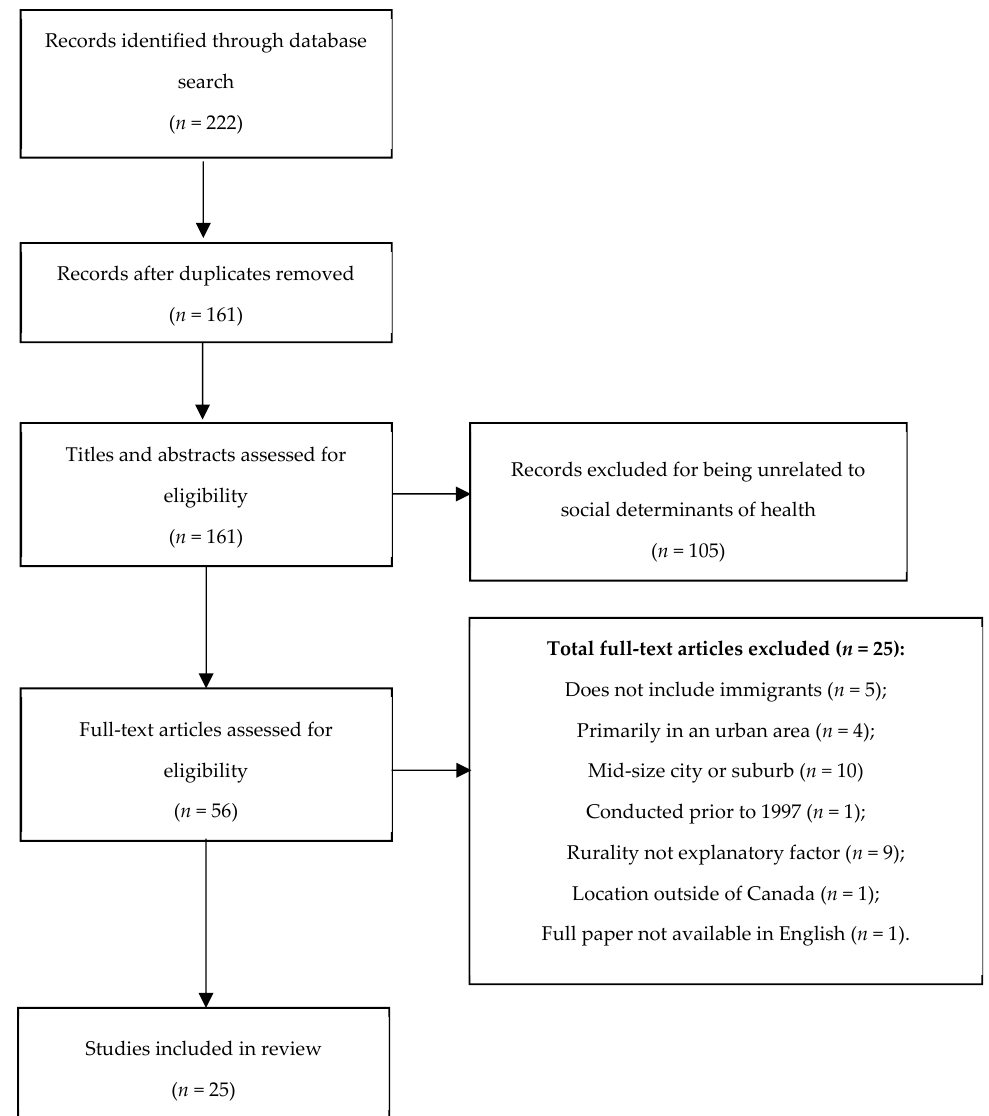
Figure 1. PRISMA chart for scoping review on immigrant settlement into rural communities and related determinants of health [70].